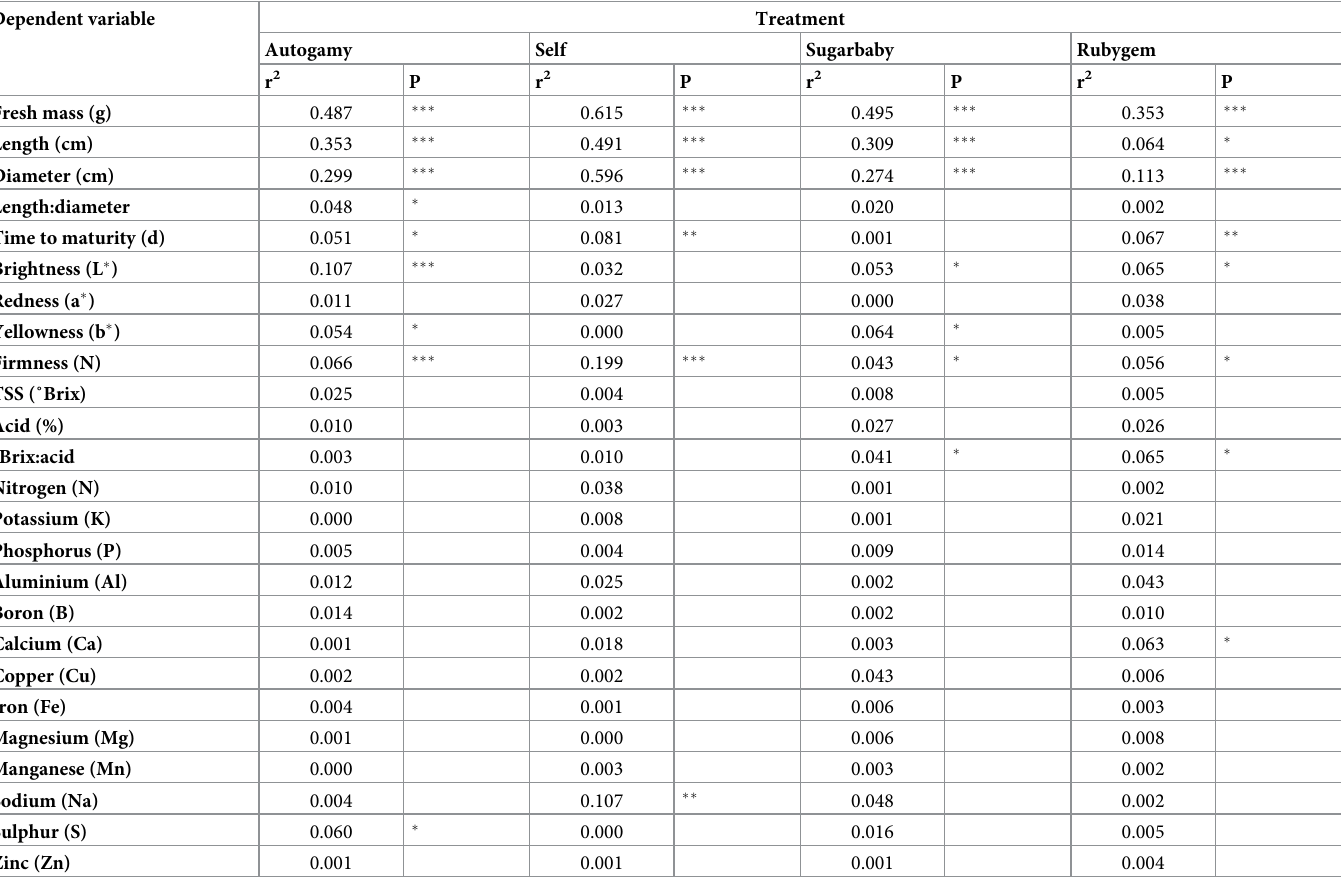
Table 3. Coefficients of determination for linear regressions between the number of fertilized seeds and the physical and chemical attributes of Redlands Joy straw- berry fruit arising from unassisted self-pollination (Autogamy) or hand-pollination with self-pollen (Self) or cross-pollen from another cultivar (Sugarbaby or